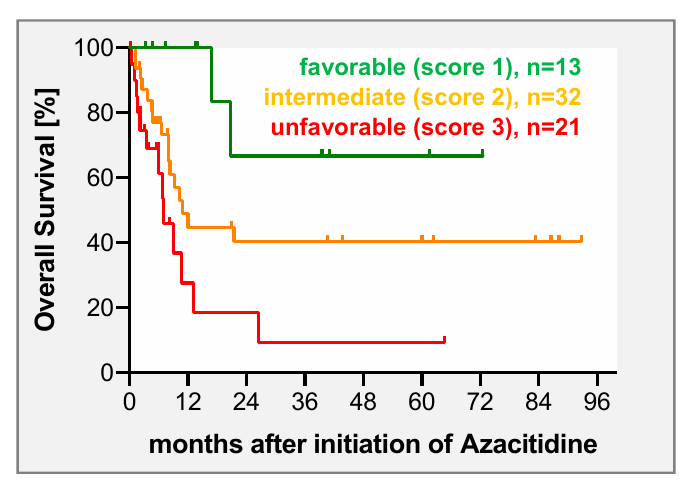
Figure 3. Overall survival (OS) after treatment with azacitidine ± DLI in 66 patients with MDS and sAML with 20–29% BM blasts (formerly RAEB-T) based on a scoring system including relapse type and pretransplant strategy. One point was assigned for molecular relapse, while two points were given for diagnosis of hematologic relapse. Upfront transplantation was assigned zero points, while for application of HMA or intensive CTX prior transplant one point was given. As such, the model enables a stratification of patients into three distinct risk categories (favorable = 1 point, intermediate = 2 points, unfavorable = 3